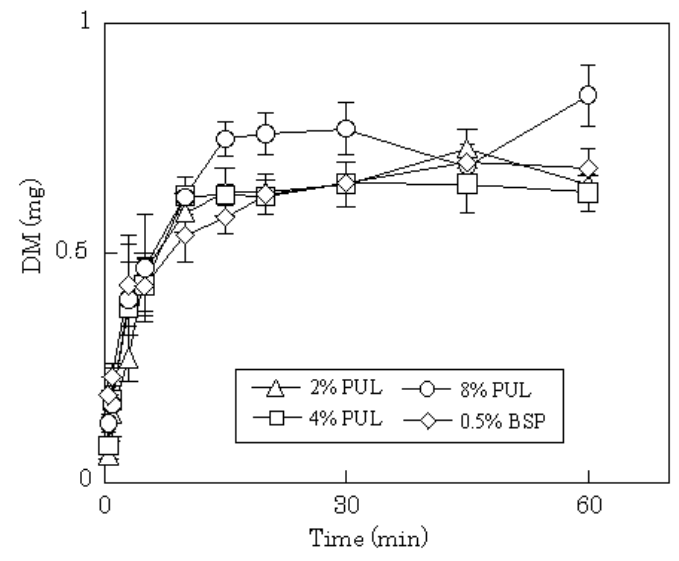
Figure 4. Release profiles of DM from FDFs in physiological